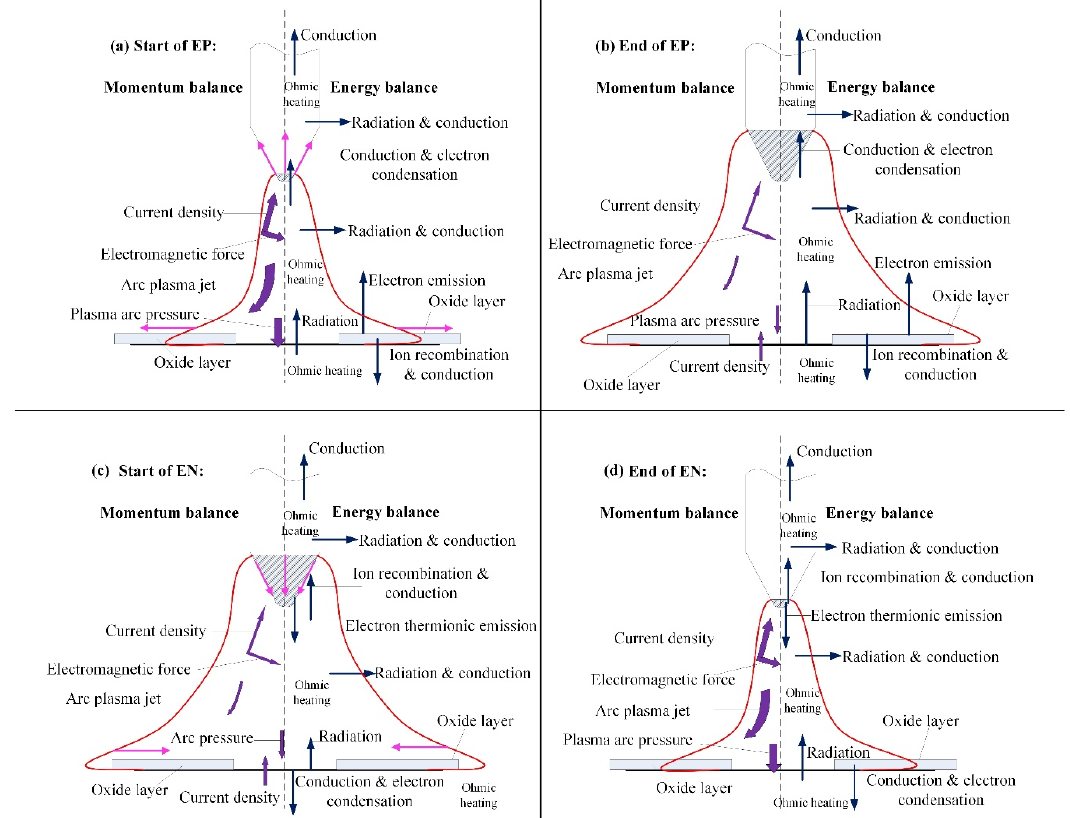
Figure 14. The energy and momentum balance of plasma arc in different polarities. ( a ) start of EP pahse; ( b ) end of EP phase; ( c ) start of EN phase; ( e ) end of EN phase.